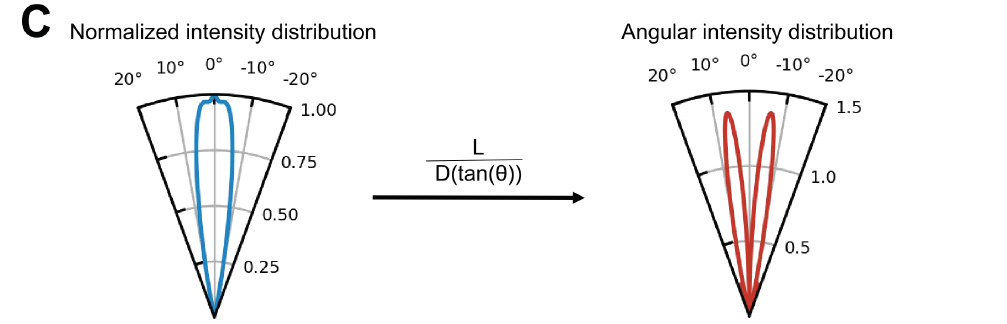
Figure A1. Configuration structure used in the simulation of a plasmonic optical fiber using ( A ) nanoparticles and ( B ) metallic thin films; ( C ) light angular distribution to reproduce the multi- mode fiber behavior.